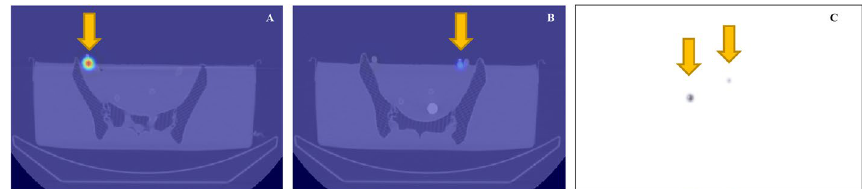
Fig. 2 SPECT/CT and planar lymphoscintigraphy images acquired from the phantom model. A Axial fused SPECT/CT images showing a SLN on the right, B same on the left, C planar lymphoscintigraphy including both SLNs. SPECT/CT, single-photon emission computed tomography combined with computed tomography; SLN, sentinel lymph node